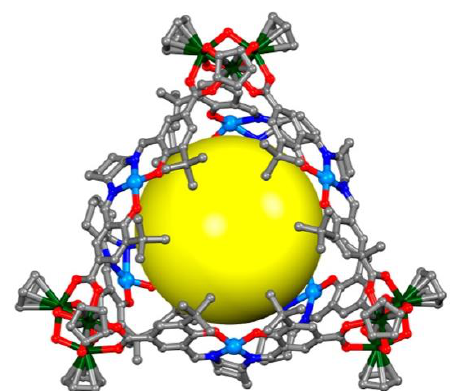
Figure 12. Single crystal X-ray structure of Mn–salen linked coordination cage. The yellow sphere highlights the hydrophobic cavity. Reprinted with permission from Reference [51]. Copyright 2018 American Chemical Society.